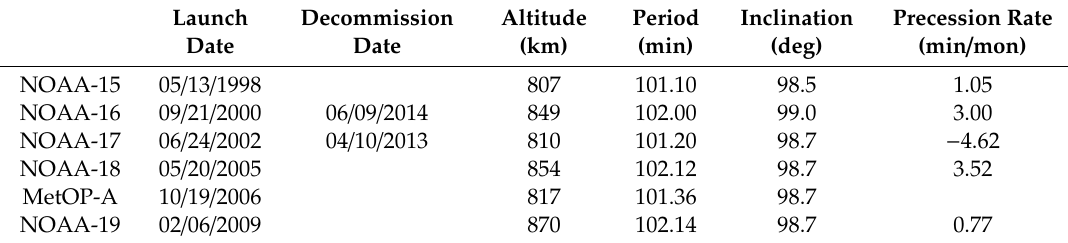
Table 1. Satellite orbital parameters.